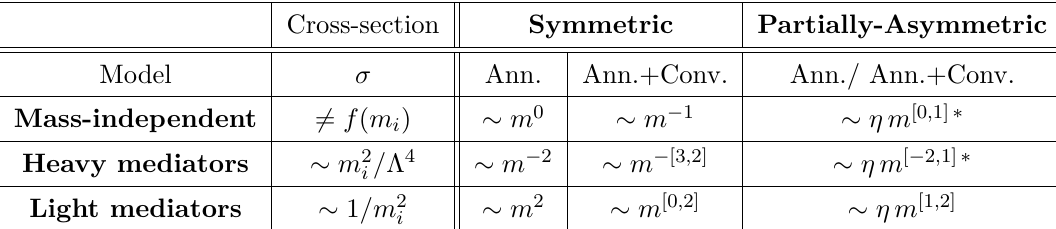
Table 2 . Scaling of the relic abundance with the DM mass for the heavier components in a multi-component DM with symmetric or asymmetric components, with and without conversions, for different types of dependence of the cross sections on the DM mass. The left/right exponents indicate the extreme limits that are obtained for strong/weak conversions (and annihilations) in the symmetric (partially-asymmetric) case. In the cases with an ∗ , left/right exponents indicate weak/strong